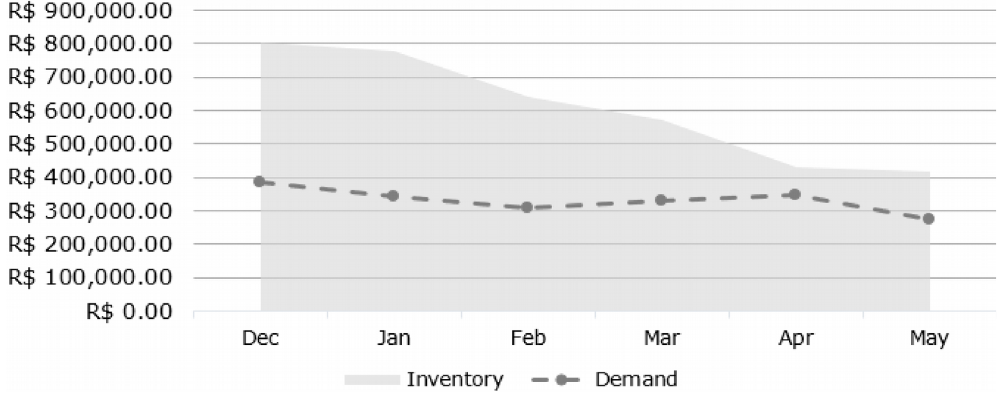
Figure 6. Total inventory value and